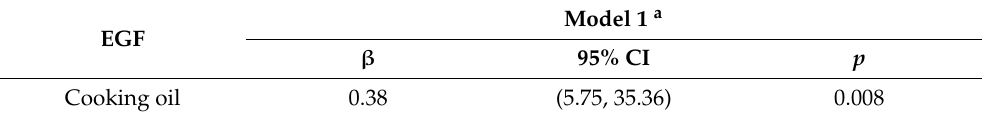
Table 6. Association between EGF and dietary food